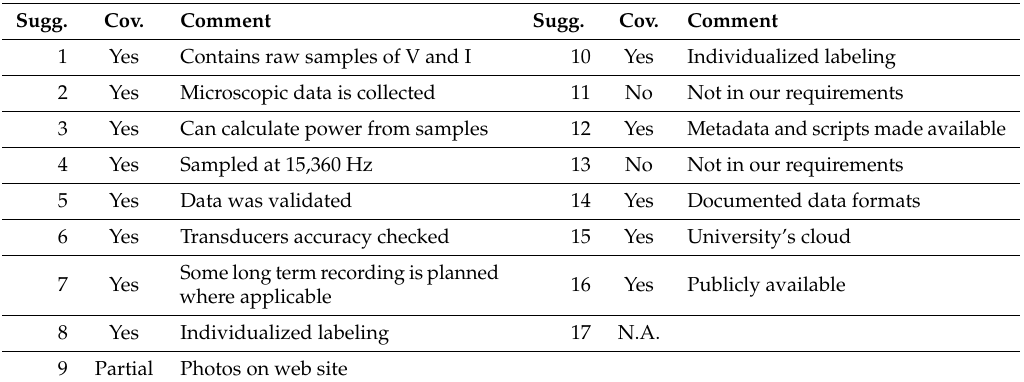
Table 4. Coverage of Klemenjak’s [38]